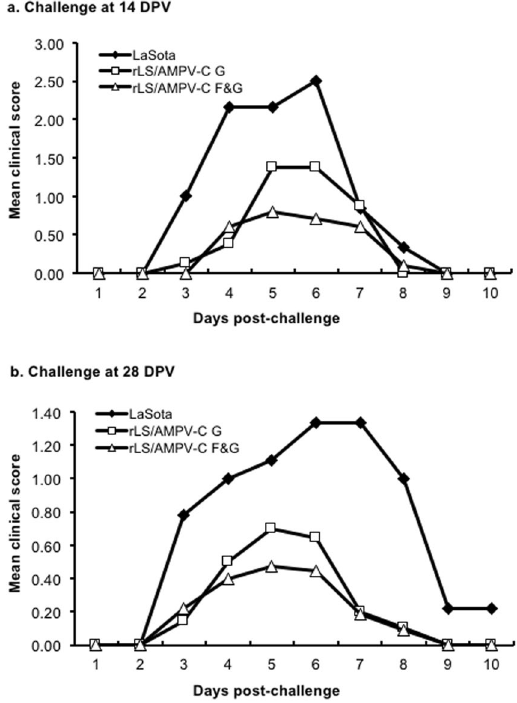
Figure 4. Mean clinical sign scores of turkeys after challenge with AMPV-C. Turkey poults were vaccinated with rLS/AMPV-C G, rLS/AMPV-C F&G, or LaSota, and challenged with the pathogenic AMPV-C at 14 ( a ) or 28 ( b ) DPV. The birds were examined daily for clinical signs and the mean scores from each group were plotted.